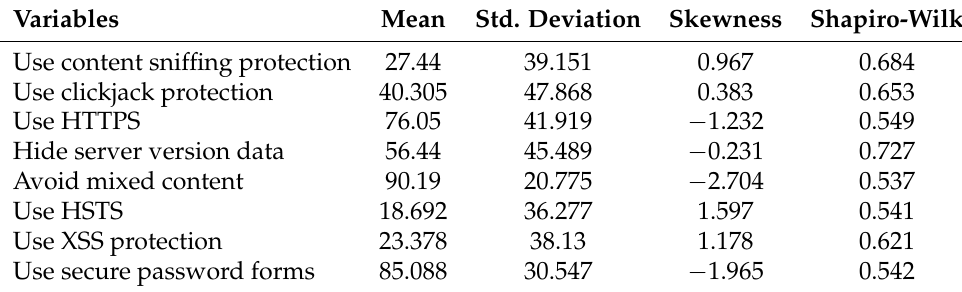
Table 6. Descriptive statistics results for the variables included within Security